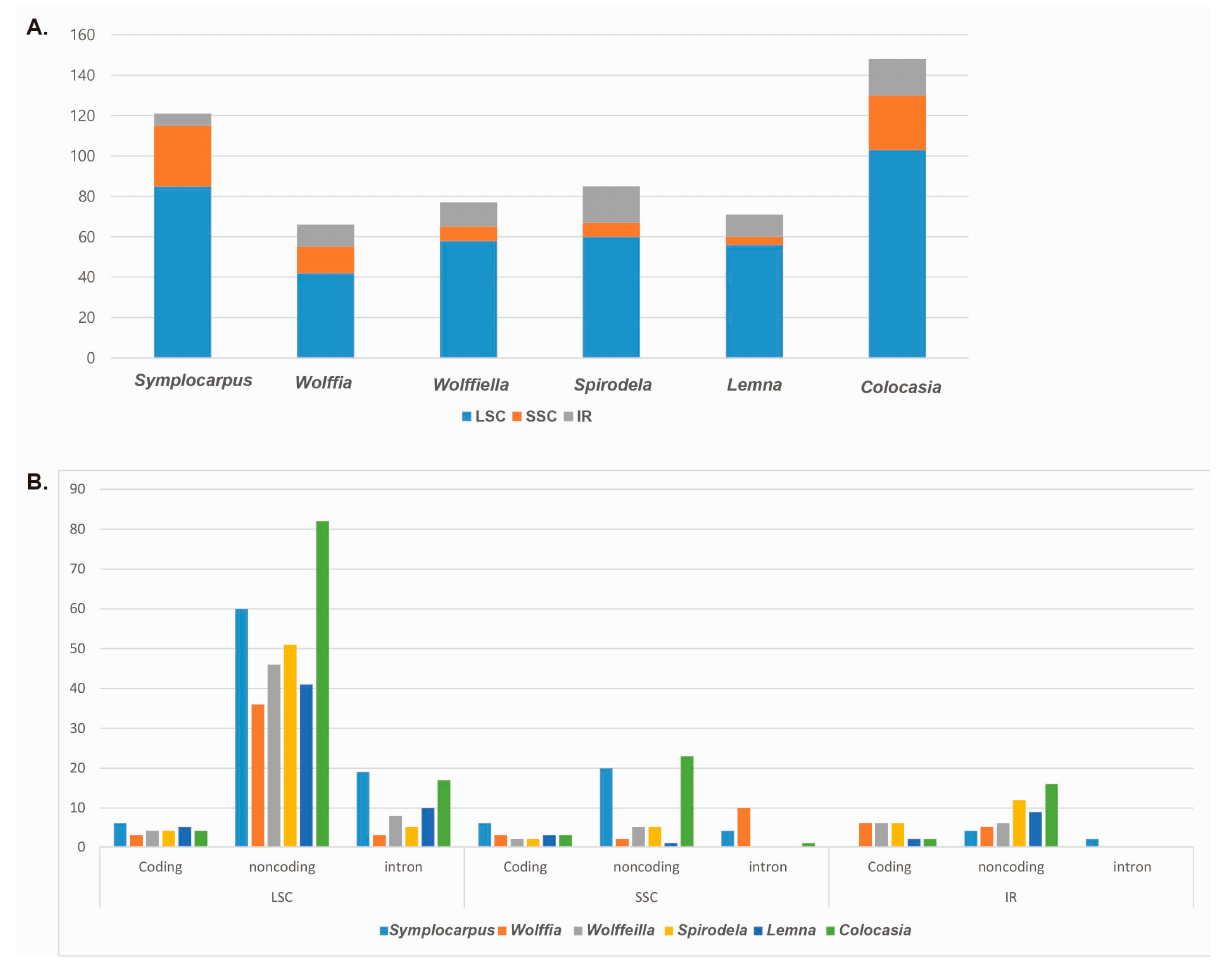
Figure 5. Analyses of simple-sequence repeats (SSRs) in the Araceae chloroplast genome. ( A ) Location of SSRs in Araceae species; ( B ) Distribution and region of SSRs in Araceae species.